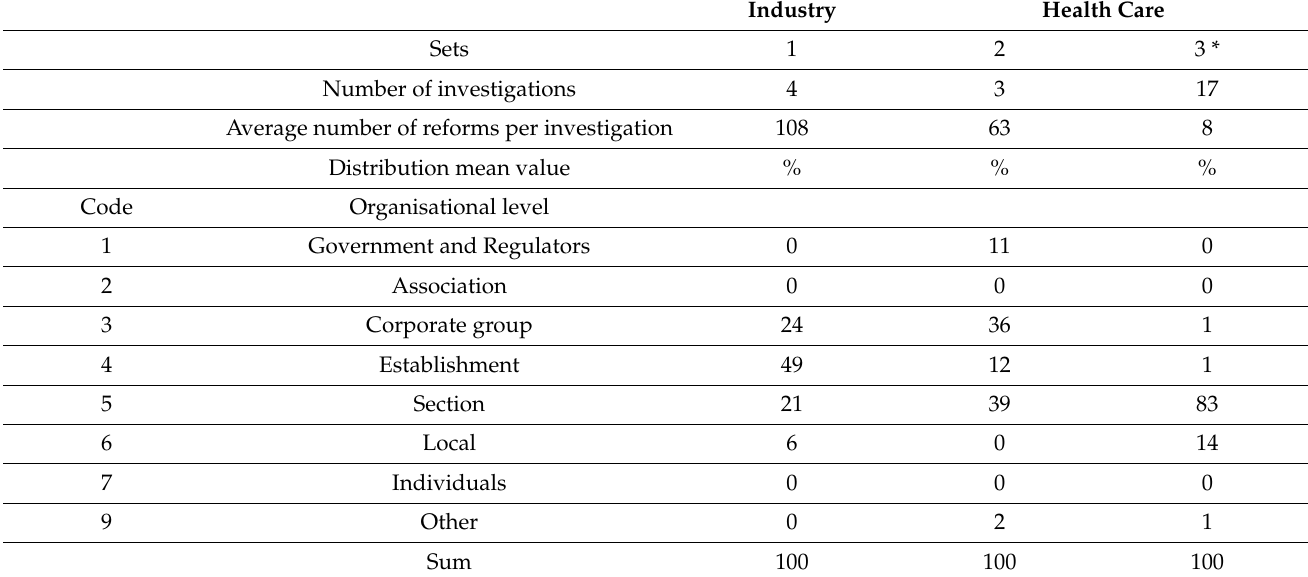
Table 8. Organisational levels of reforms from three sets of investigations with mean values of distributions. Industry Health